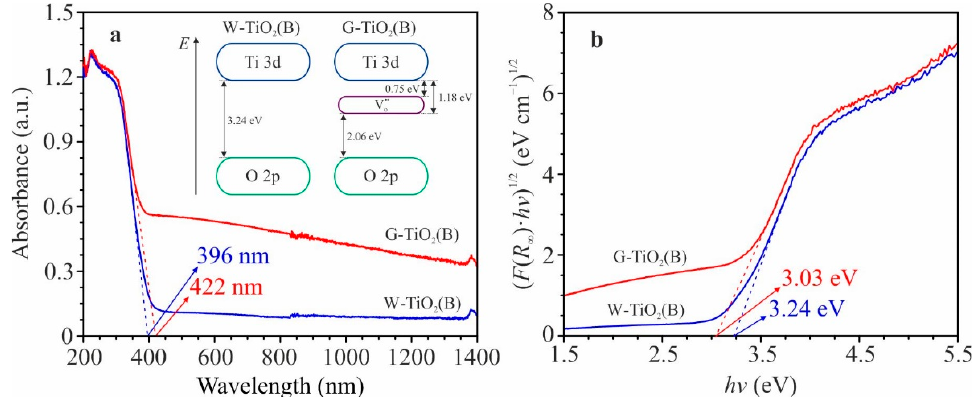
Figure 3. UV-Vis-NIR absorption spectra registered in the diffuse reflectance mode ( a ) and Tauc’s plots ( b ) for W-TiO 2 (B) and G-TiO 2 (B) . The insert shows a schematic representation of band gap